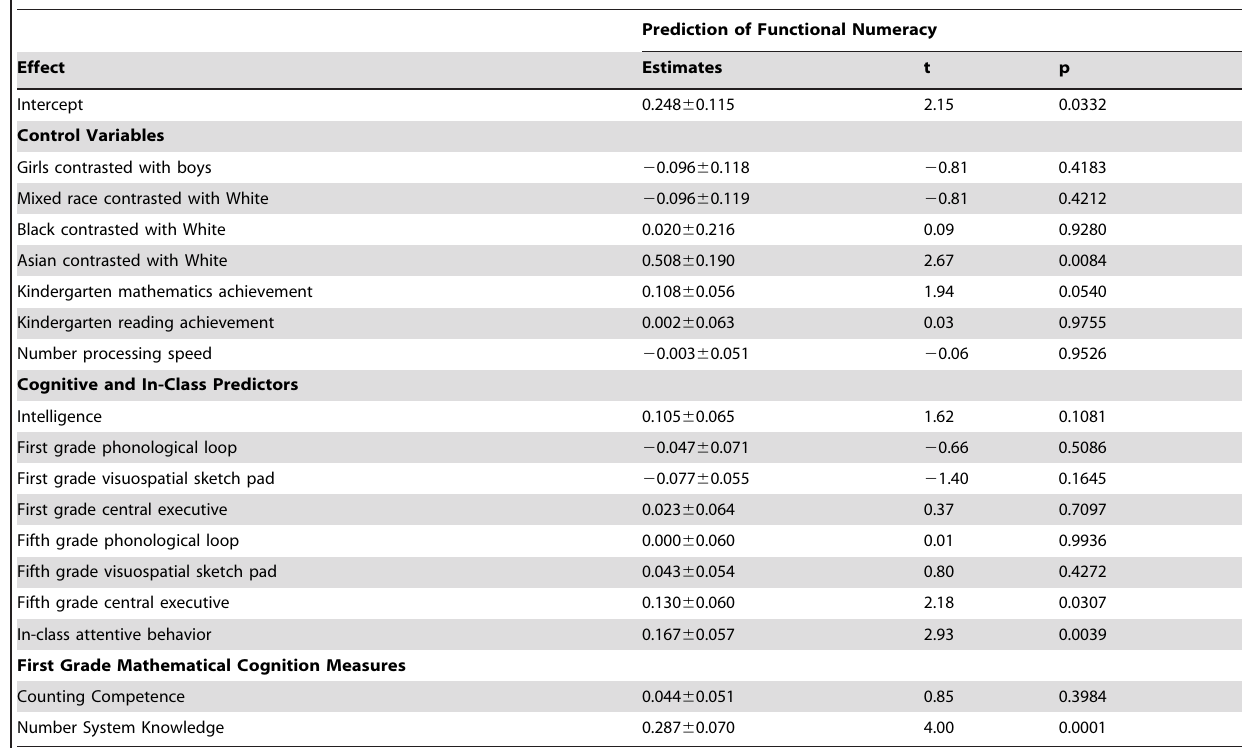
Table 2. Ordinary Least Squares Estimates ( 6 standard errors) for Prediction of Adolescent Functional